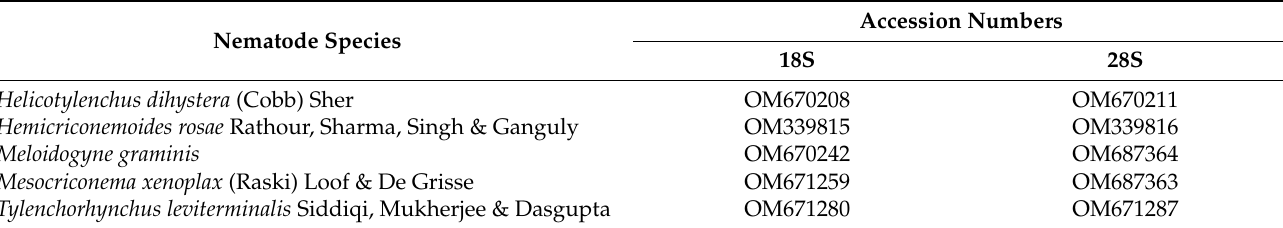
Table 2. Nematode species and accession numbers in the GenBank